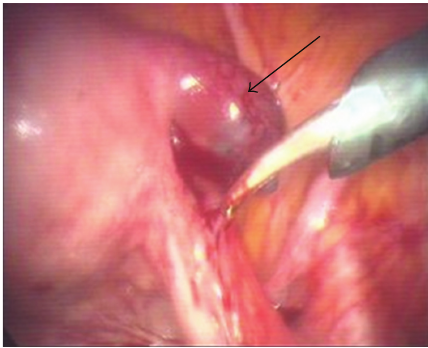
Figure 1: Ectopic pregnancy in remnant of right rube (arrow).